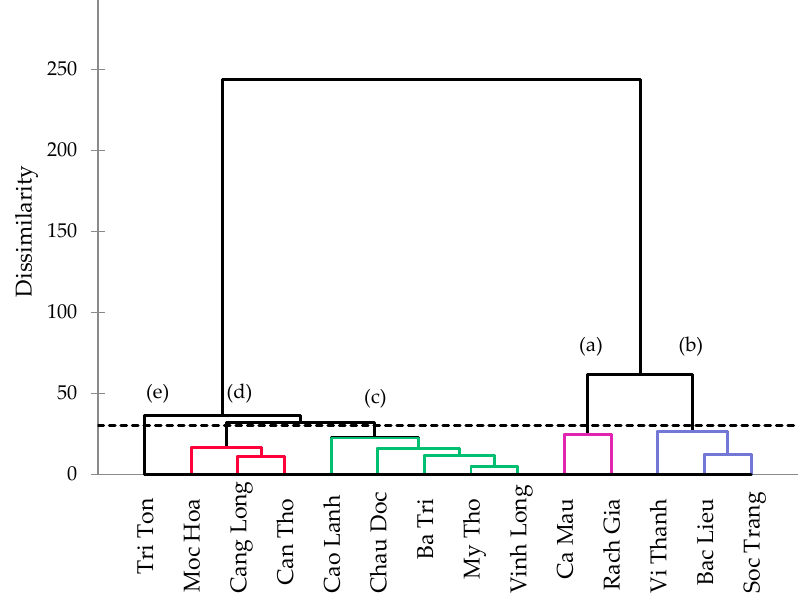
Figure 2. The 14 meteorological stations in the VMD were divided into five clusters based on the SPI 12 ‐ month drought over a period of 40 years: ( a ) Cluster No.1 (Ca Mau, Rach Gia), ( b ) Cluster No.2 (Vi Thanh, Bac Lieu, Soc Trang), ( c ) Cluster No.1 (Cao Lanh, Chau Doc, Ba Tri, My Tho, Vinh Long), ( d ) Cluster No.4 (Moc Hoa, Cang Long), and ( e ) Cluster No.3 (Tri Ton).